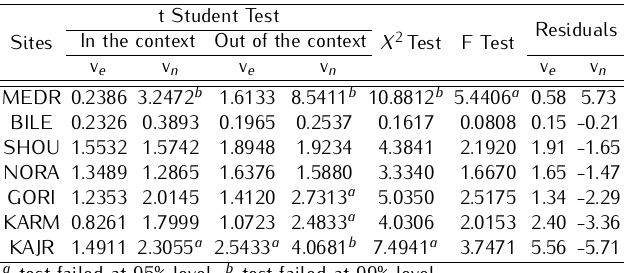
Table 5. Tests results (block B4). The results of the statistical tests for the GPS site data components. The sites passed from all the tests are the accepted data. The tests have been performed in two confidence levels (95% and 99%).